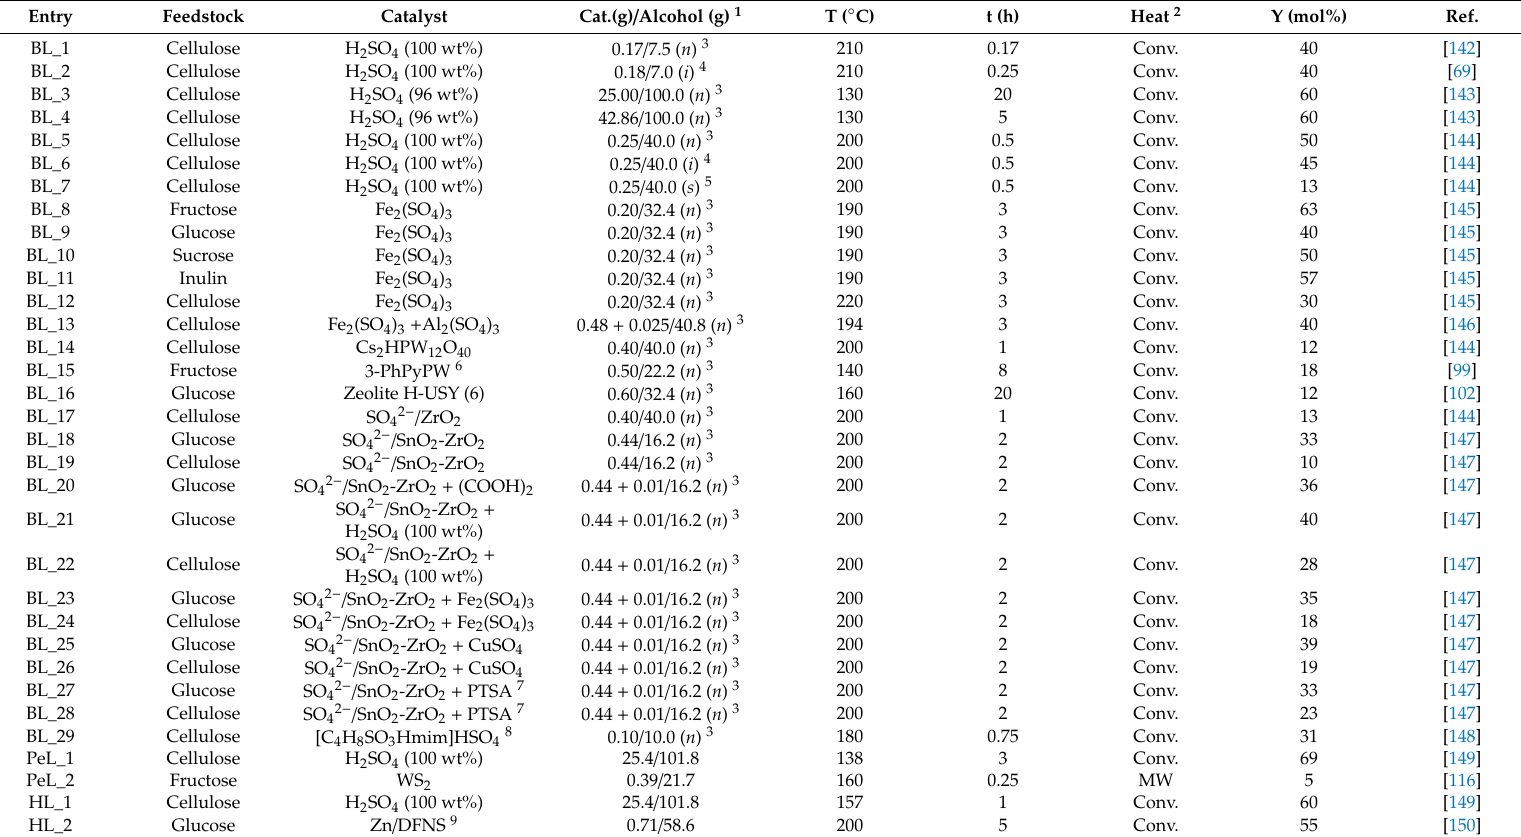
Table 14. Catalysts for the butyl levulinate (BL), pentyl levulinate (PeL), and hexyl levulinate (HL) production from C6 model